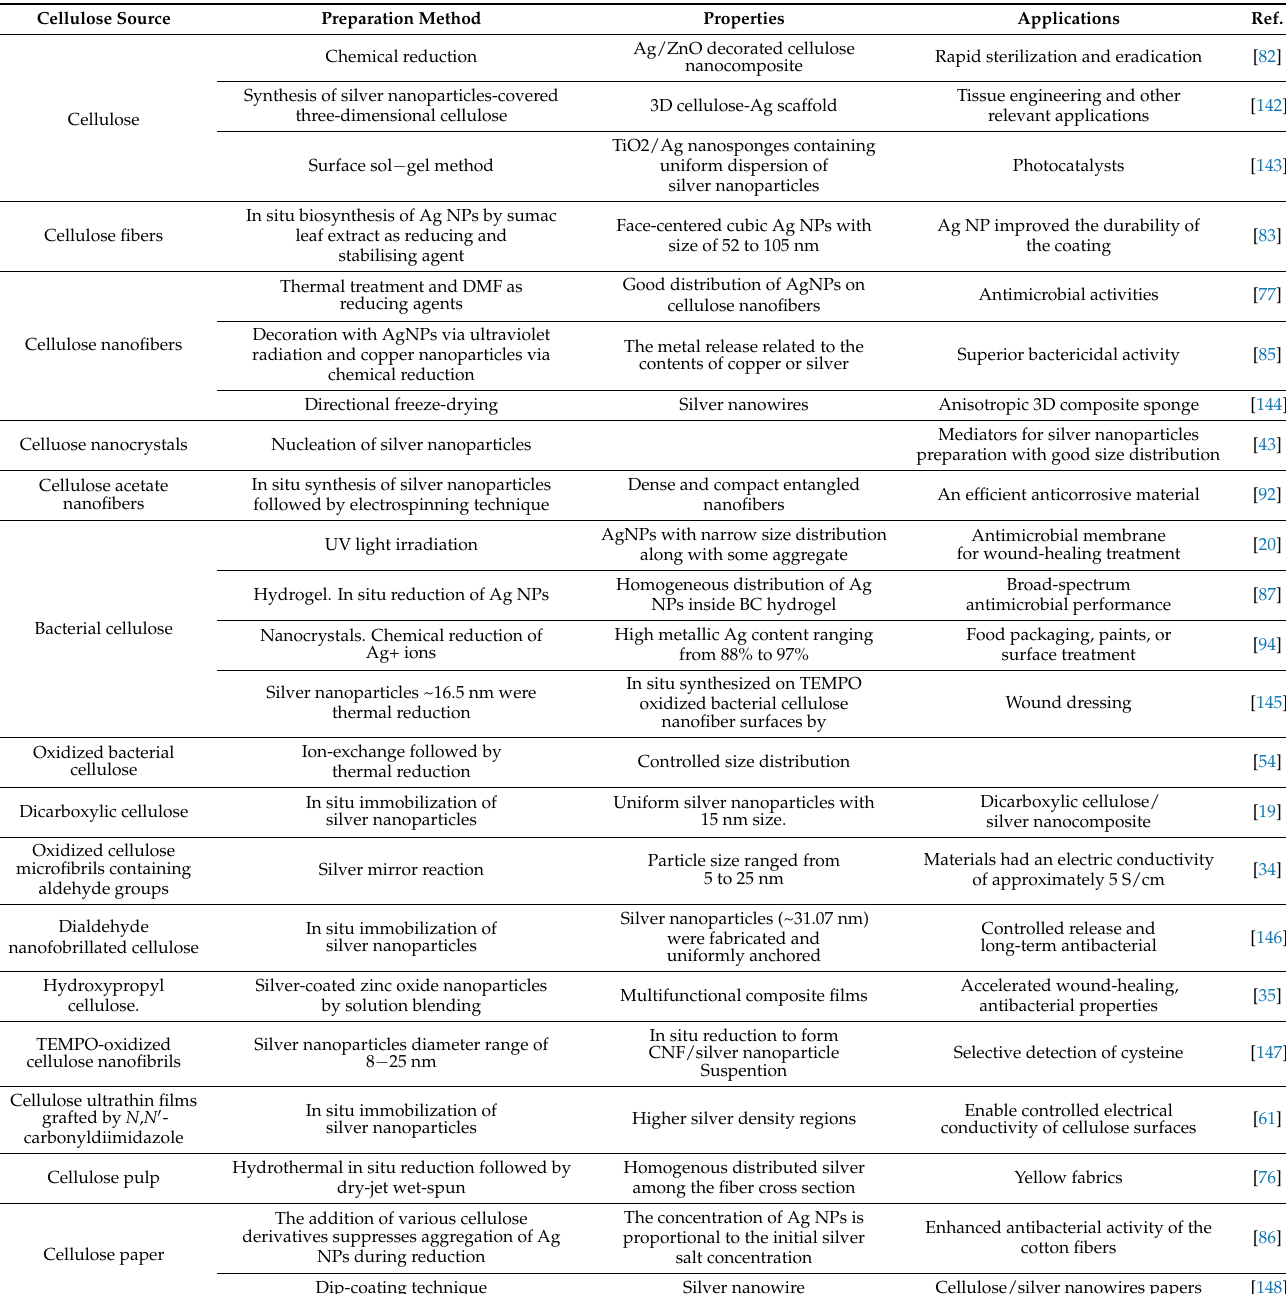
Table 1. Cellulose/silver nanocomposites: summary of preparation methods, properties, and